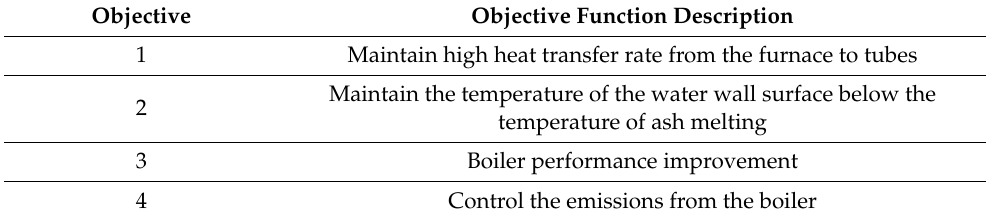
Table 6. Main objective